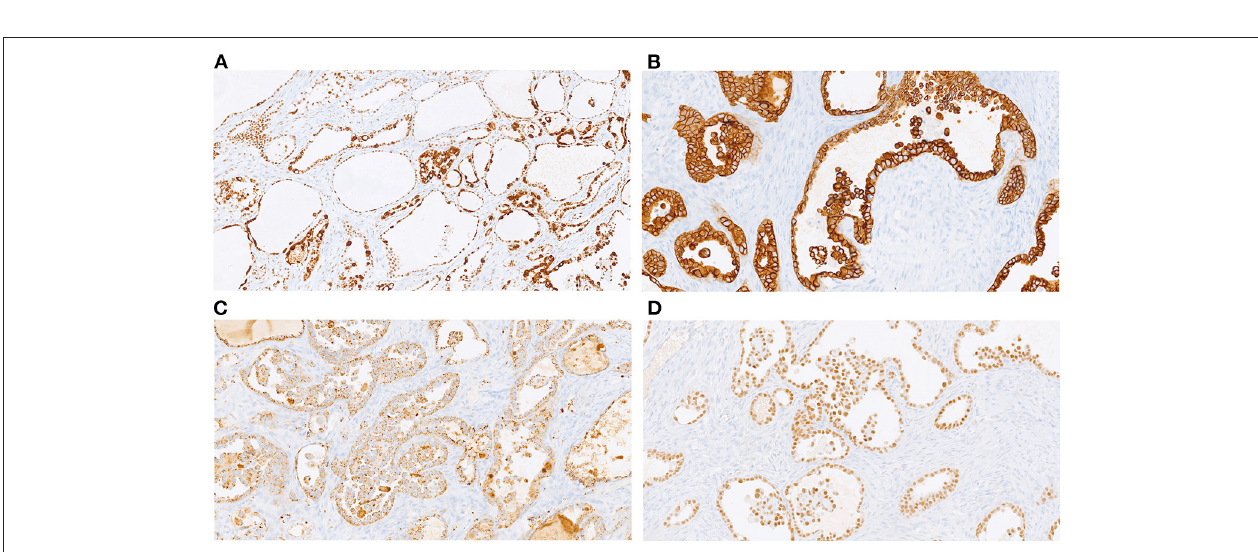
FIGURE 2 | Histological images of the tumor. Carcinoma with papillary and tubule-cystic architecture. The cells exhibit clear and eosinophilic cytoplasm and hyperchromatic nuclei with mild to moderate atypia (arrow) ( A ; H&E, 5x). Dilated cysts lined by flattened cells with benign-appearing nuclei intermixed with atypical papillae (arrow) ( B ; H&E, 10x). Occasional small groups of clear cells (arrow) ( C ; H&E, 10x). Irregular infiltrating glands with dense fibrous stroma (arrow) ( D ; H&E, 10x).